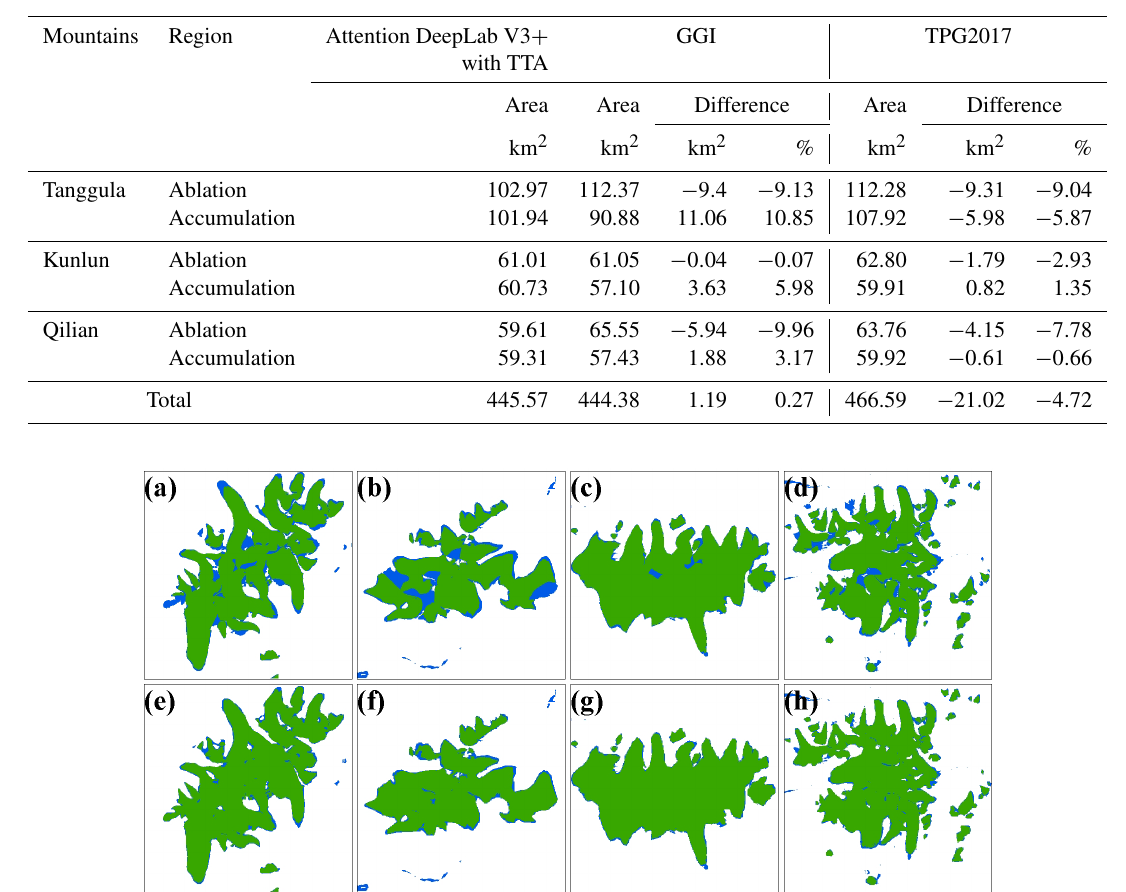
Table 3. Summary of glaciers in GGI, TPG2017 and our data.